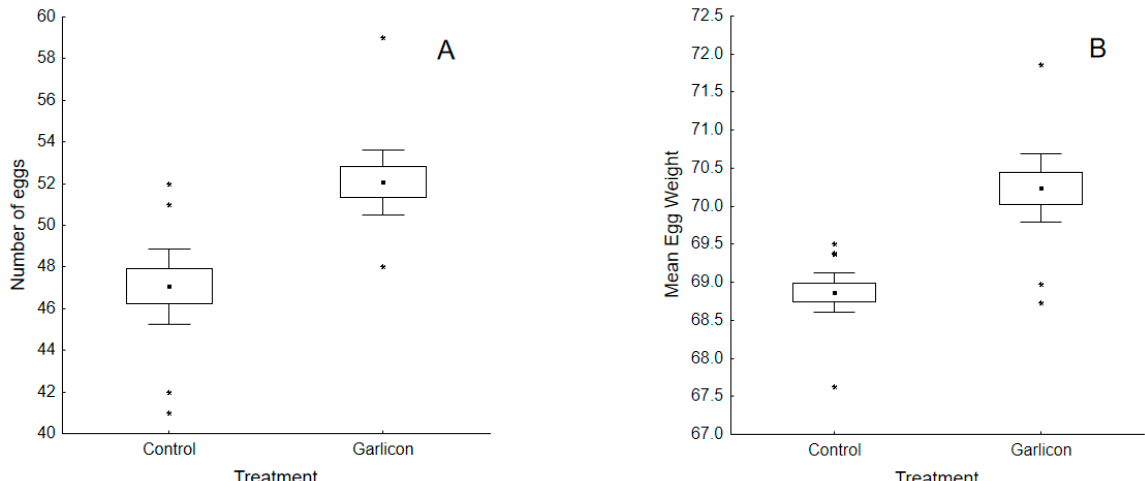
Figure 1. Differences in the mean number of eggs ( A ) and mean egg weight ( B ) produced by control and experimental laying hens. Control hens were fed a basal diet while experimental ones were fed a basal diet supplemented with a commercial Alliaceae extract. In both cases, the number of eggs and egg weight were significantly higher in the experimental group fed the Alliaceae extract. Whiskers show 95% confidence interval and asterisks indicate outliers. Outliers are represented with *.